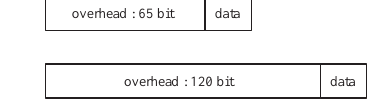
Figure 7 . Packet Overhead for CAN 2.0A and